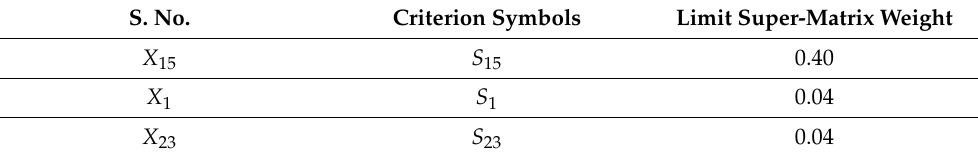
Table 6. Weights of the switches for the controller placement in cluster 3 (purple). S. No.